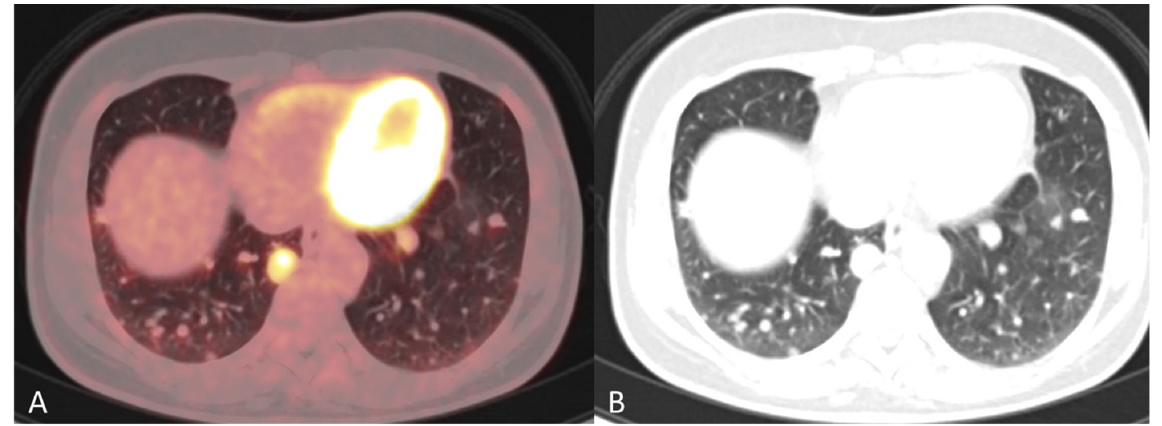
Figure 4. ( A ) Baseline axial PET/CT fused and ( B ) axial CT shows several non-enlarged retroperito- neal lymph nodes with high metabolic activity ( A , B , arrows). The lymph nodes were not suspicious for malignancy on CT alone.